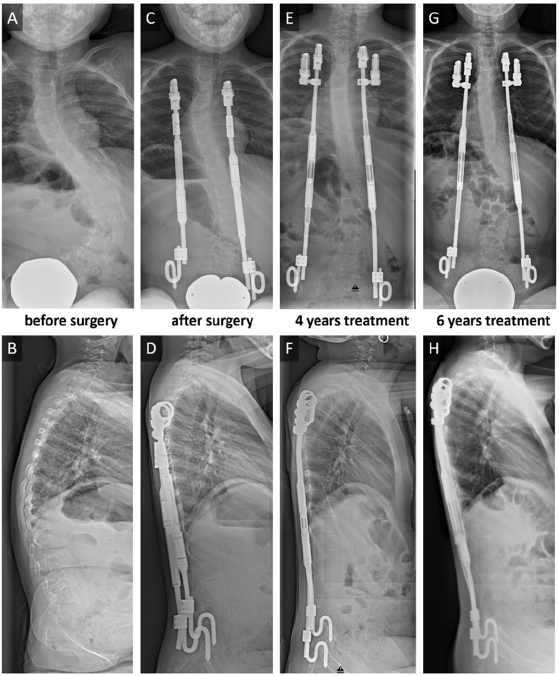
Figure 1. Bilateral rib-to-pelvis fixation with magnetically controlled growing rods (MCGR) in a 5-year-old spinal muscular atrophy type II girl with progressive scoliosis. Posterior anterior (p.a.) ( A ) and lateral ( B ) sitting radiographs before the surgical intervention. Deformity correction ( C/D ) after surgical treatment. Implant exchange after maximal distraction after 3 years of treatment. 4-year follow-up ( E/F ) with second MCGRs. 6-year follow-up ( G/H ) with fully distracted